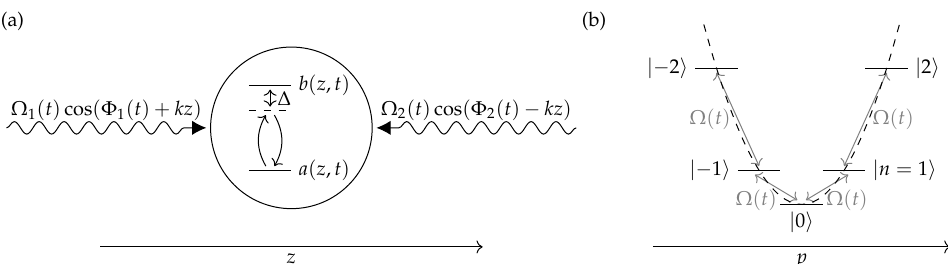
Figure 1. Interaction of an atom with interferometer laser fields in the Bragg regime. ( a ) Two-level = a ( z , t ) + b ( z , t ) atom described as Ψ ( z , t ) in the coordinate representation with the two- g e | (cid:105) | (cid:105) | (cid:105) level transition off-resonantly driven by two fields counter-propagating along the z axis, g e | (cid:105) ↔ | (cid:105) with a detuning ∆ and time-dependent amplitudes Ω 1 ( t ) and Ω 2 ( t ) and time-dependent phases Φ 1 ( t ) and Φ 2 ( t ) . ( b ) Momentum space ladder corresponding to momentum n n | (cid:105) between neighboring levels being driven by the effective pulse amplitude Ω ( t )